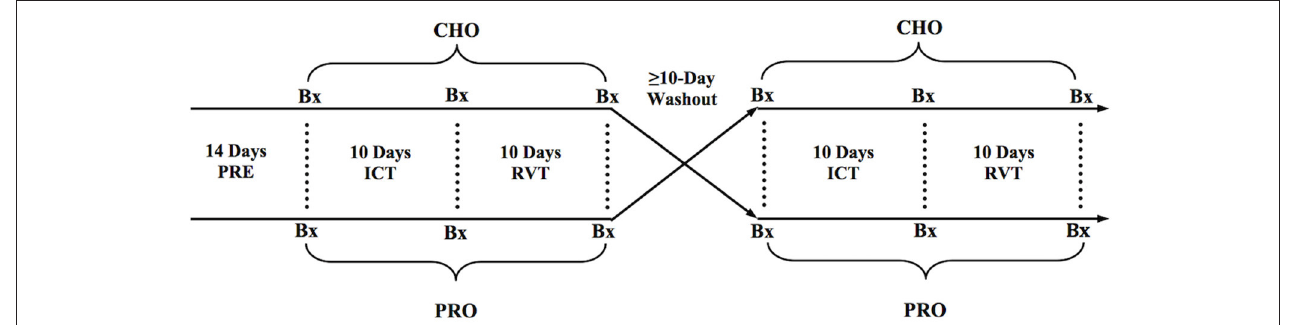
FIGURE 1 | General experimental design. Bx, Skeletal muscle biopsy.